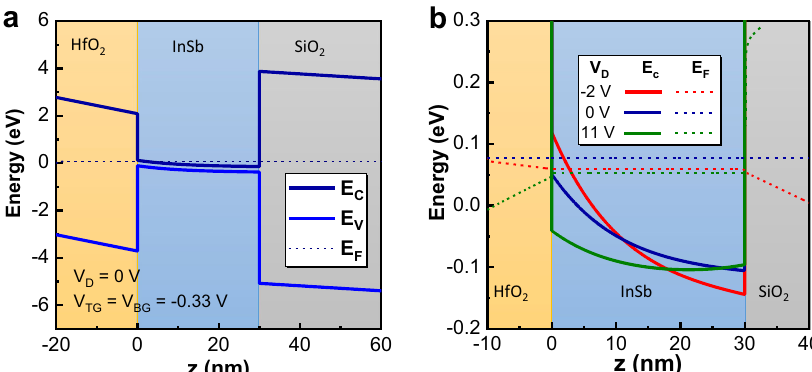
Fig. 4 Simulated band diagrams. a Simulated energy band diagram of the HfO 2 – InSb – SiO 2 structure in the device at V D = 0 V (with V BG = V TG = − 0.33 V). The conduction and valence band edges E c and E v , are marked by the dark blue and light blue solid lines, while the Fermi level E F is marked by the dark blue dashed line. b Zoom-in plots (red, blue, and green solid lines) showing the details of the conduction band edges inside the InSb nanosheet at three different values of V D . The red, blue, and green dashed lines mark the Fermi levels obtained in the simulations at the three different values of V D